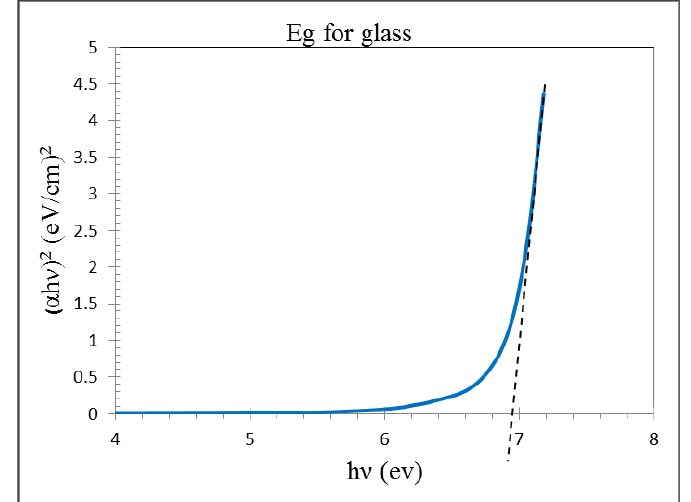
Fig.6: The optical band gap for glass-graphene thin